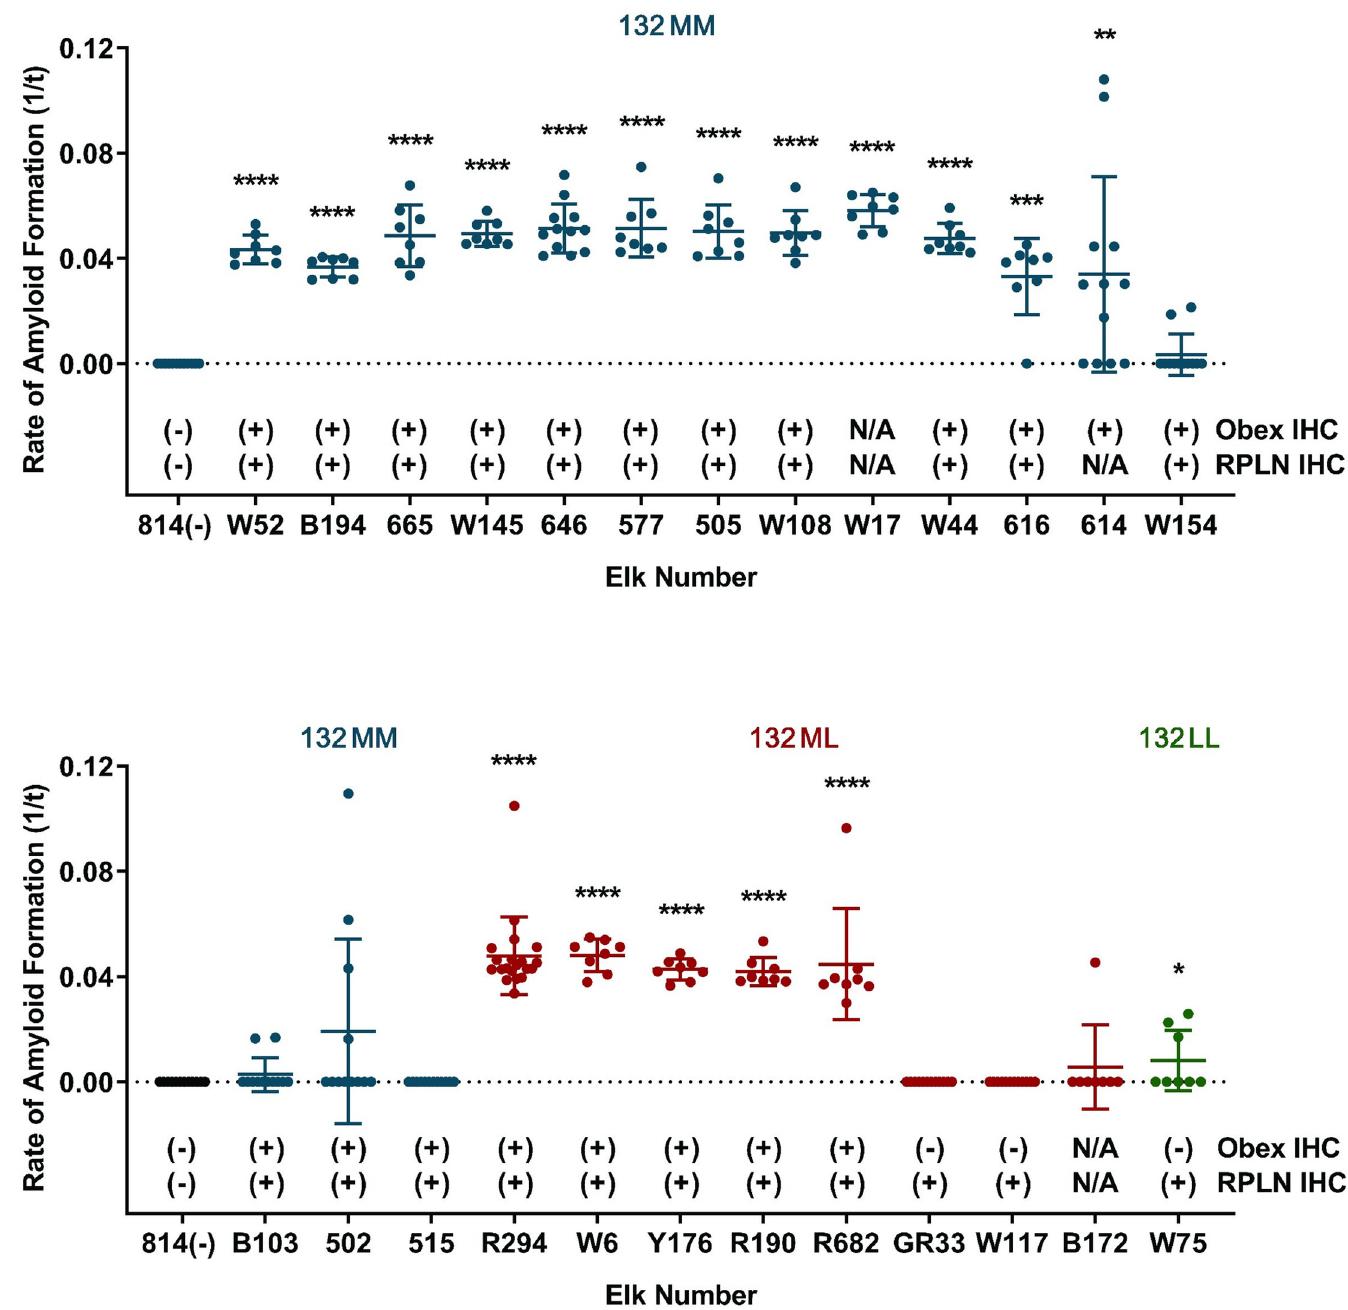
Fig 5. Detection of PrP CWD in asymptomatic elk by RT-QuIC and IHC. RT-QuIC detection of PrP CWD in asymptomatic elk demonstrated statistically significant detection in third eyelids of 18 of 25 (72%) animals ( ���� p < 0.0001, ��� p < 0.001, �� p < 0.01, � p < 0.05, two-tailed Mann-Whitney test compared with negative controls). PrP CWD immunoreactivity was detected in 22 of 22 (100%) retropharyngeal lymph node samples and 20 of 23 (87%) obex samples of by IHC. Data are presented as PrP CWD positive or negative by genotype: 132MM (blue), 132ML (red), 132LL (green), tissue type and test method. Each third eyelid sample is represented by the mean and standard deviation from at least eight replicates. Abbreviations: RPLN, retropharyngeal lymph node; IHC, immunohistochemistry.